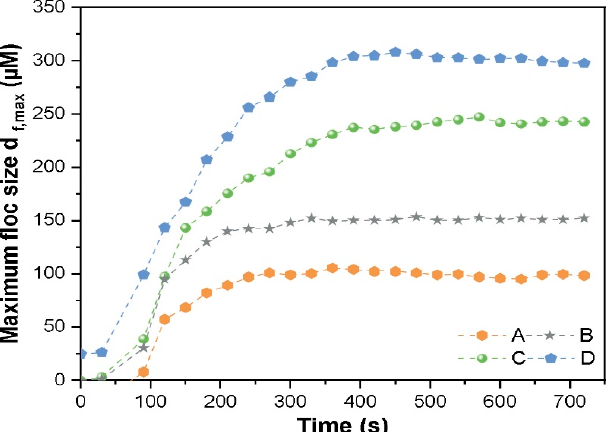
Figure 6. Size of composite floc of nano-CuO (2.5 mg/L) under various conditions at ( A ) 50 mg/L PAFC, ( B ) 50 mg/L PAFC + 20 mg/L MC, ( C ) 50 mg/L PAFC with 3 mg/L PAM and ( D ) 50 mg/L PAFC + 3 mg/L PAM and 20 mg/L MC.